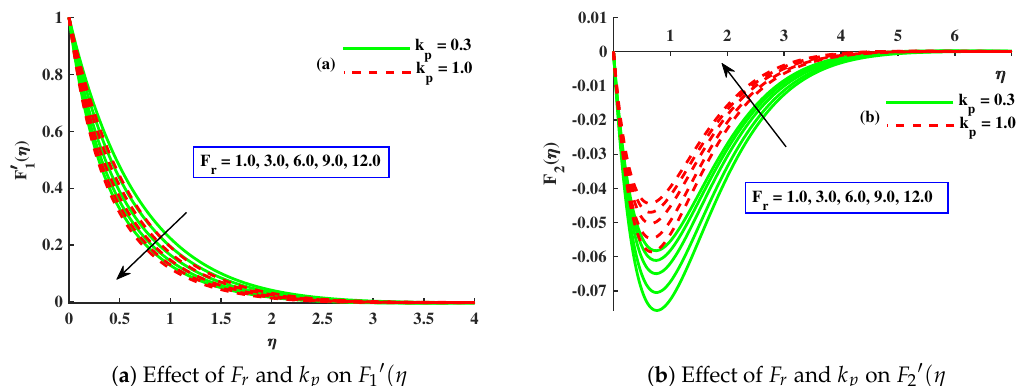
Figure 4. Curves of F 1 (cid:48) ( η ) andF 2 ( η ) along the Forchheimer number ( F r ) and porosity factor ( k p ).